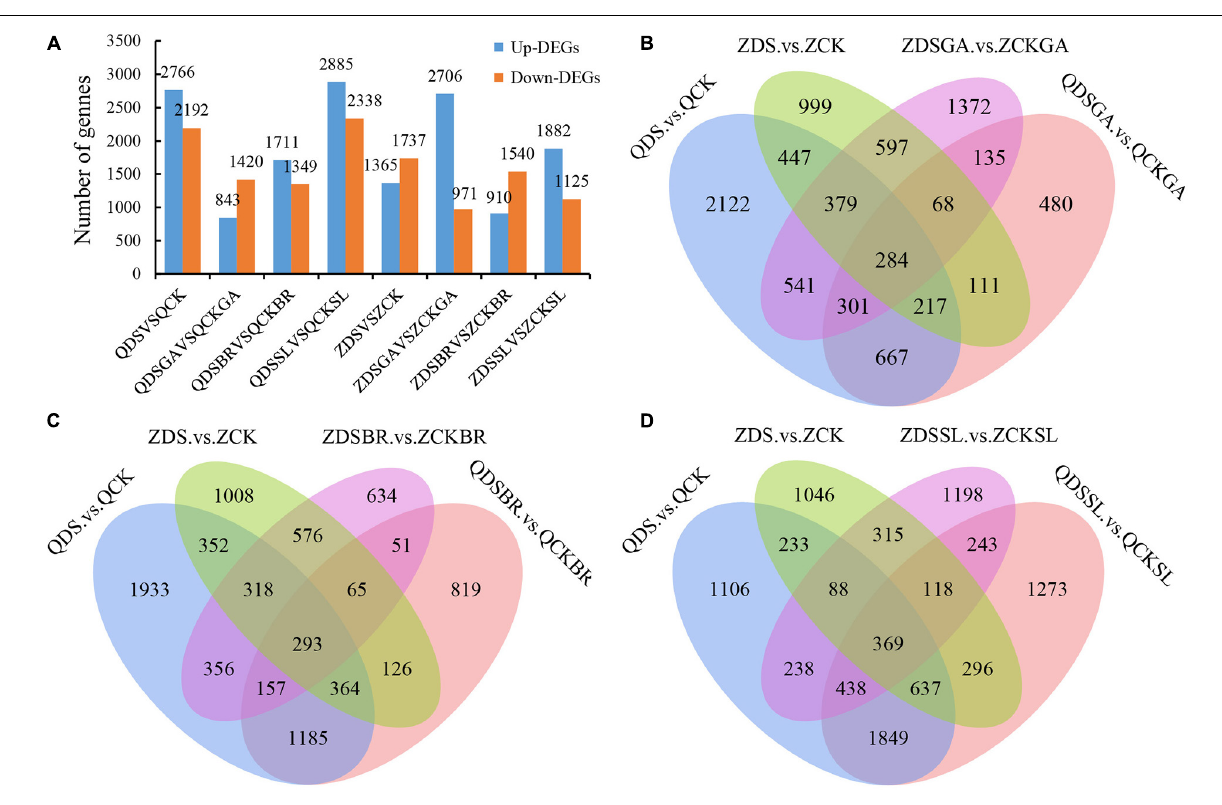
were up regulated and 1,125 DEGs were down regulated in Zi330 after adding exogenous SL under deep sowing